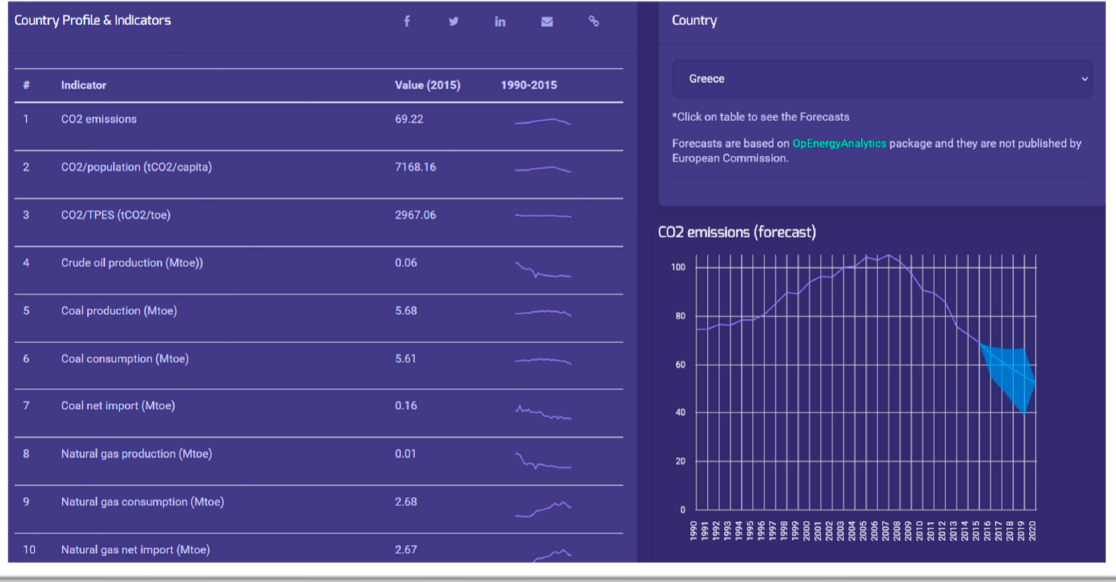
Figure 7. Energy Profile of an EU country along with the time series visualization on CO 2 emissions until 2020.